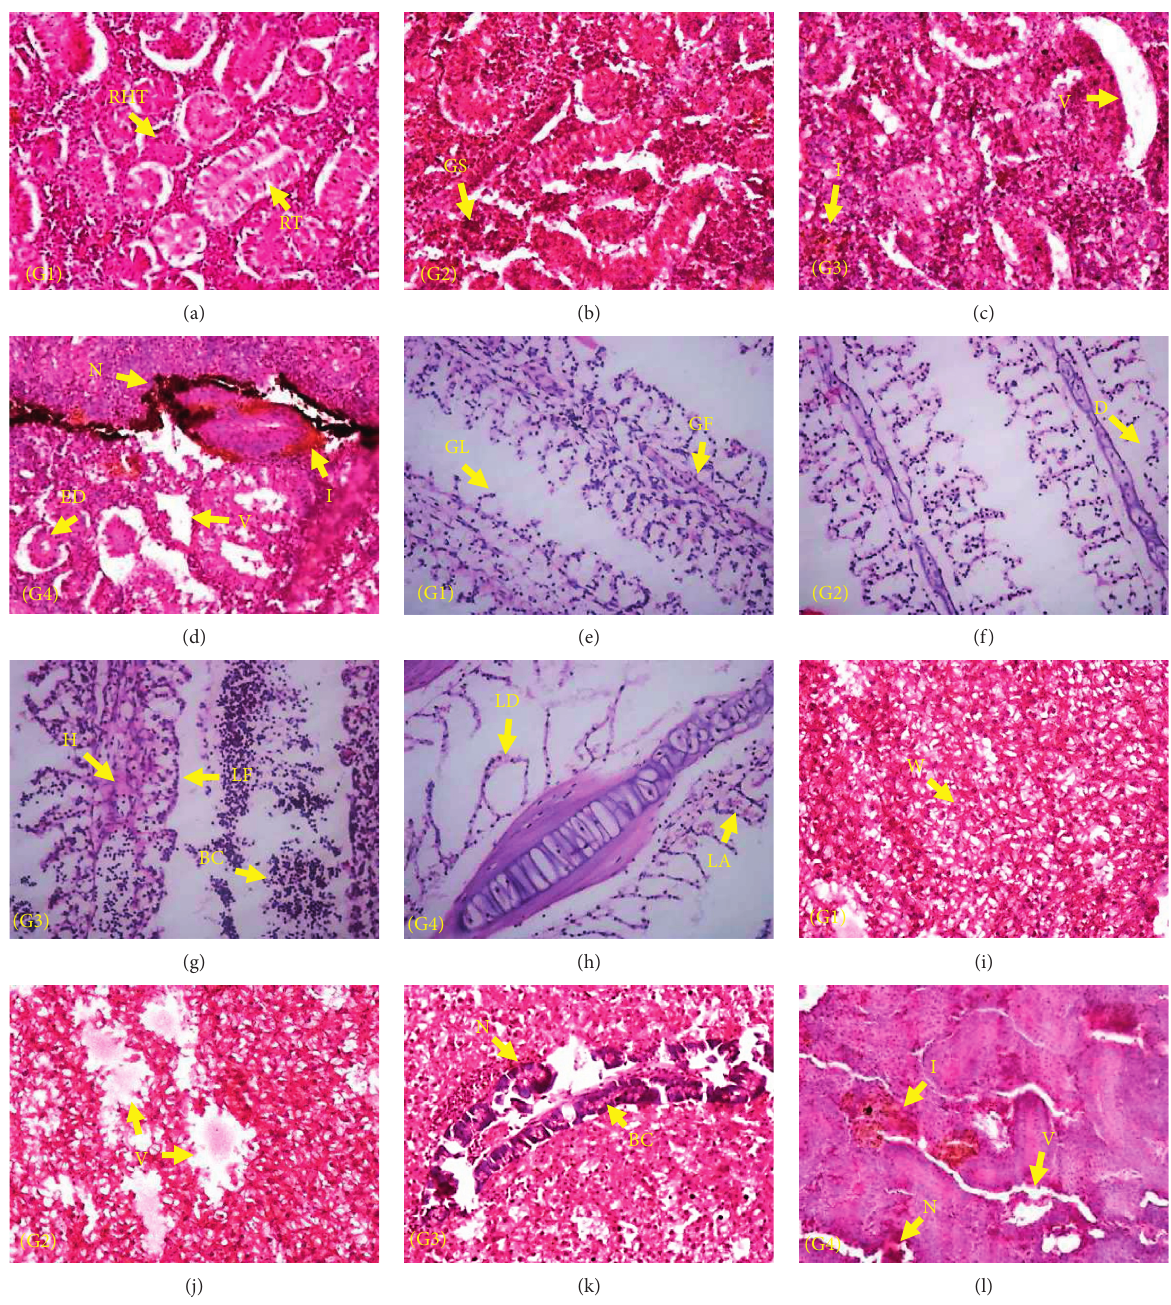
Figure 4: (a–d) Histology of kidney. G1 showed normal structure of renal tubules (RT) and renal hematopoietic tissue (RHT). G2 kidney showed glomerulus shrinkage (GS), G3 vacuolation (V) and inflammation (I), and G4 necrosis (N) and epithelial desquamation (ED). (e–h) Histology of gills. G1 showed normal structure of gills, gill filament (GF), and gill lamella (GL). G3-G4 showed degeneration (D), lamellar fusion (LF), hemorrhage (H), blood congestion (BC), lamellar disorganization (LD), and lamellar aneurysm (LA). Histology of liver. Hepatocytes (H), vacuolation (V), necrosis (N), blood congestion (BC), and inflammation (I) (G1: control, G2:1 mg/l, G3: 10mg/l, and G4: 20mg/l). Images were captured at